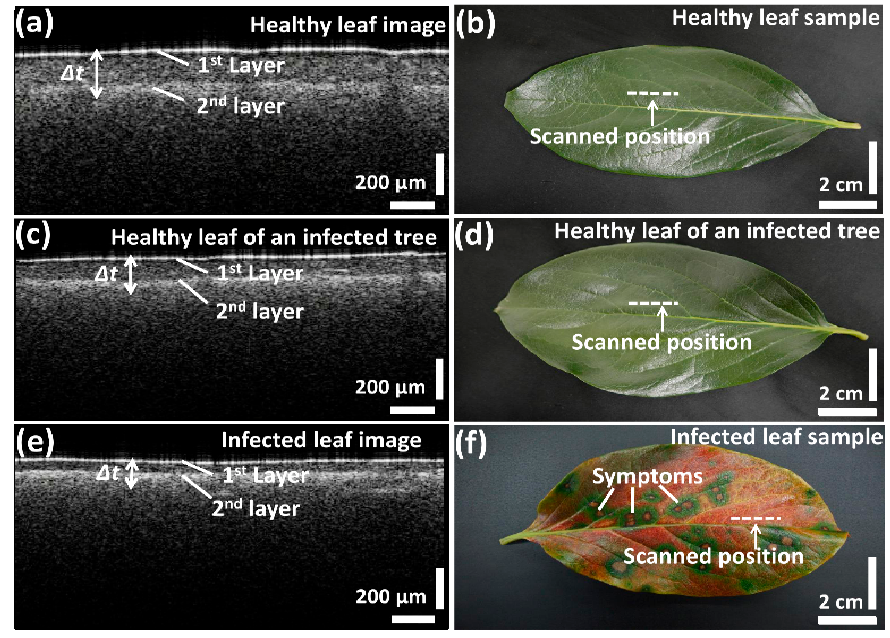
Figure 2. Two-dimensional SS-OCT images and photographs of the leaf samples; ( a , b ) healthy leaf; ( c , d ) healthy leaf of an infected tree; ( e , f ) infected leaf. ( c , d ) healthy leaf of an infected tree; ( e , f ) infected